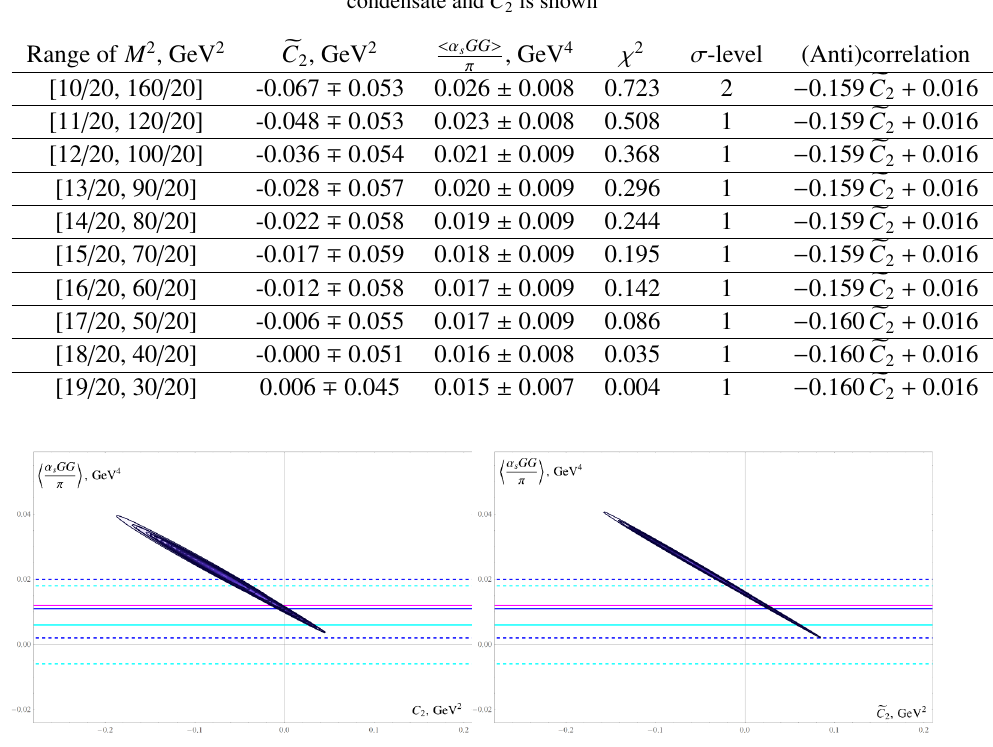
Figure 2. The regions of χ 2 ≤ χ 2 panel) with the dependence of the gluon condensate on C 2 with Λ = 0 . 25 GeV